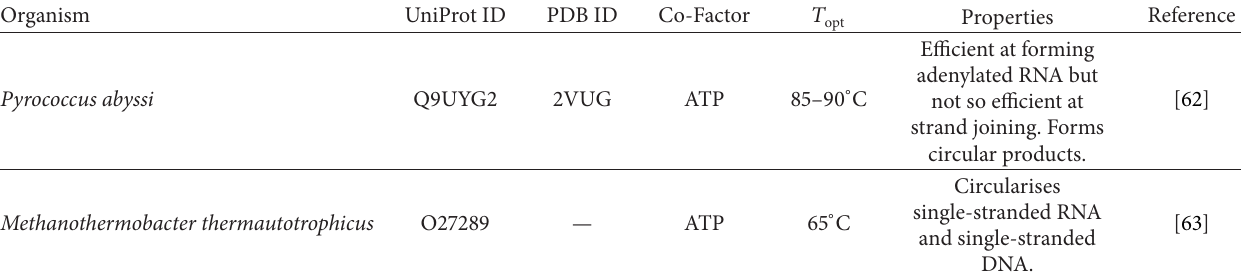
Table 2: Properties of archaeal RNA